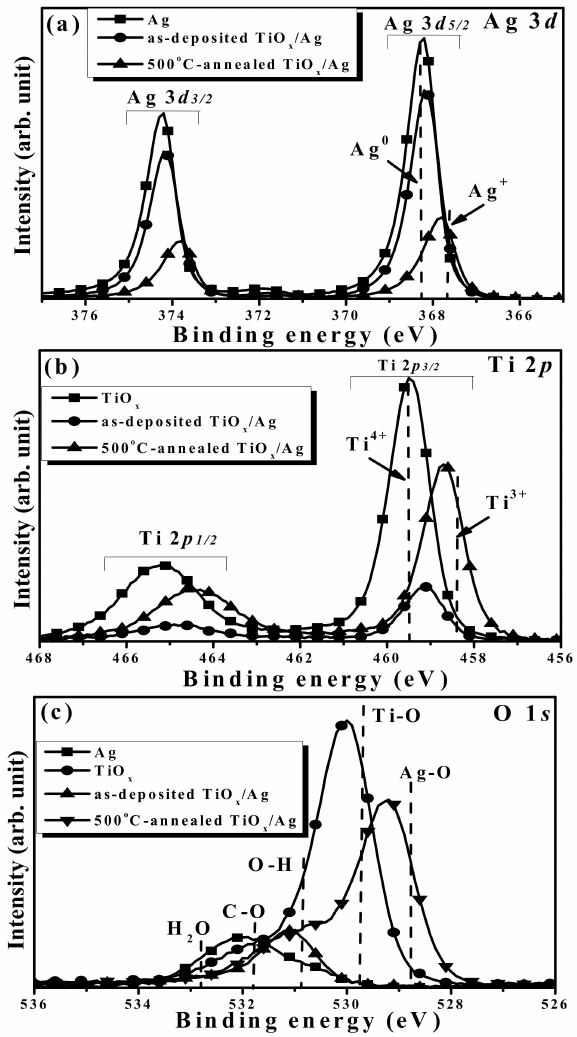
Figure 8. Binding energy spectra of the ( a ) Ag 3d, ( b ) Ti 2p, and ( c ) O 1s core levels measured from the surface of the as-deposited and 500 ◦ C-annealed TiO x /Ag structures (the individual Ag and TiO x films are also given as